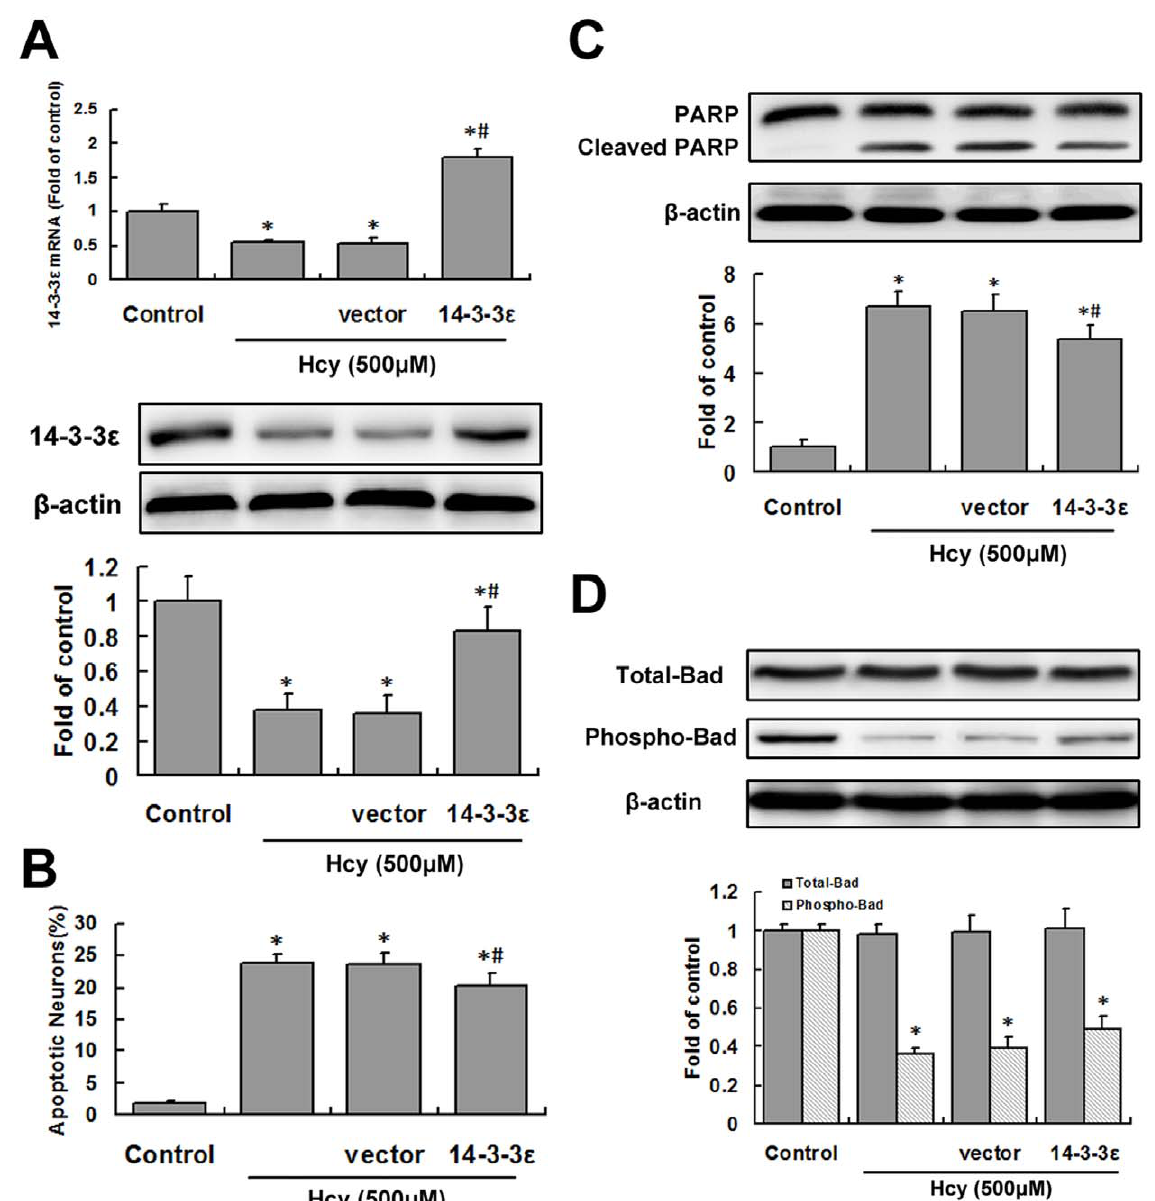
Figure 2. The effect of lentiviral 14-3-3 e transduction on apoptosis in hippocampal neurons. Hippocampal neurons transduced with lentiviral 14-3-3 e for 48 h were treated with Hcy for 24 h. A, 14-3-3 e mRNA and proteins were analyzed by real-time quantitative PCR or western blotting, respectively. B, The percentages of neurons with apoptotic nuclei (Hoechst staining) were quantified. C, Cleaved PARP was determined by western blotting. D, Total Bad and phospho-Bad levels were assessed by western blotting and densitometric analysis. * P , 0.05 vs. control. # P , 0.05 vs. Hcy treatment group.